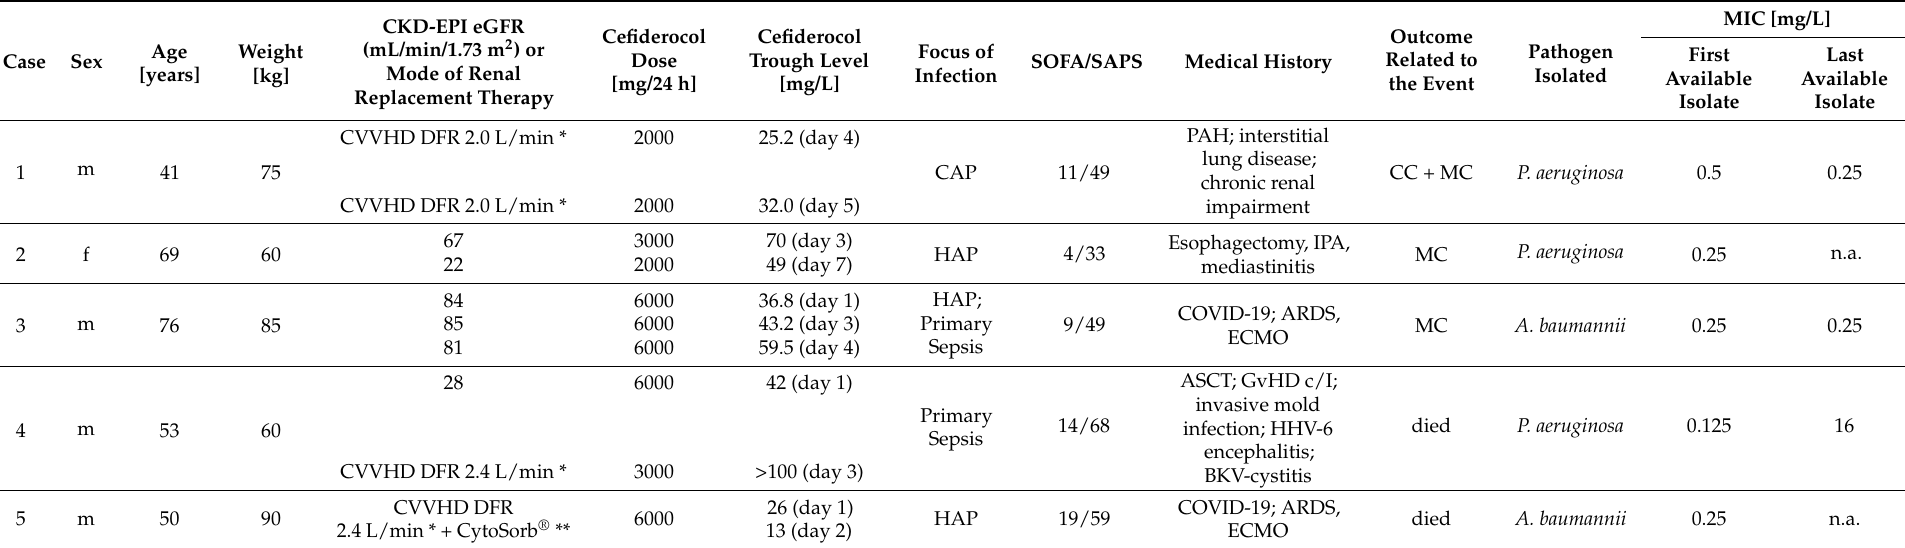
Table 1. Demographic data, extracorporeal therapies and microbiological